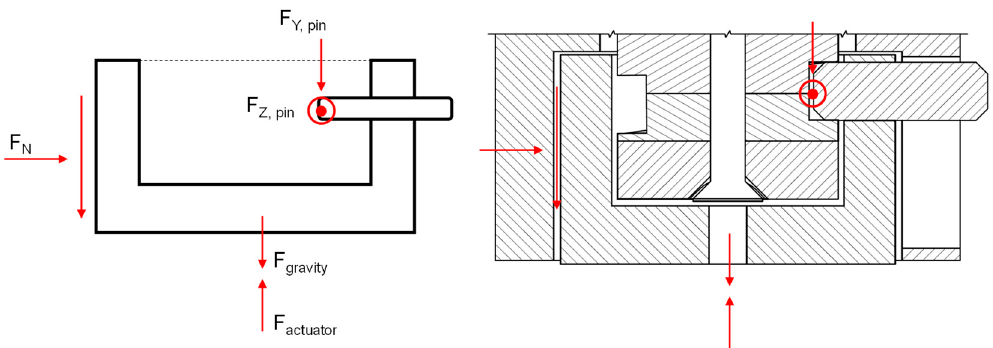
Figure 12. Generation of the force at the transmission element and, thus, the resulting actuator force.